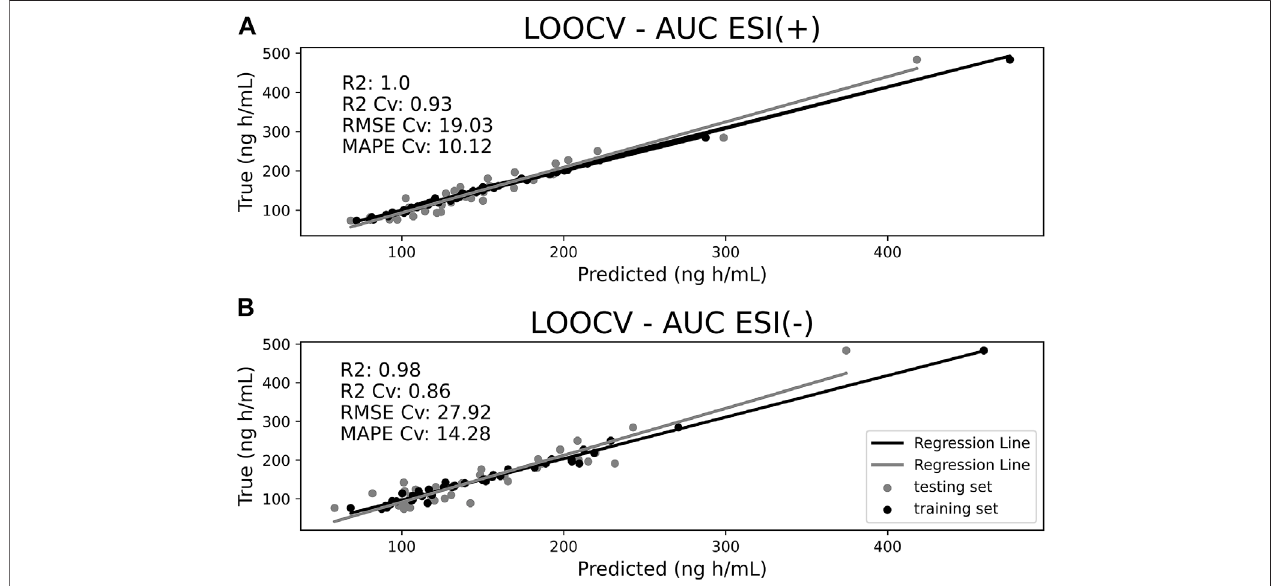
FIGURE3| Areaundercurve (AUC)predictions forESI(+) (A) andESI ( − ) (B) datasets comparing trainingsamples(black dots) withleave-one-out cross-validation (LOOCv) testing samples (gray dots). X -axis represents model-predicted values and Y -axis the true values.